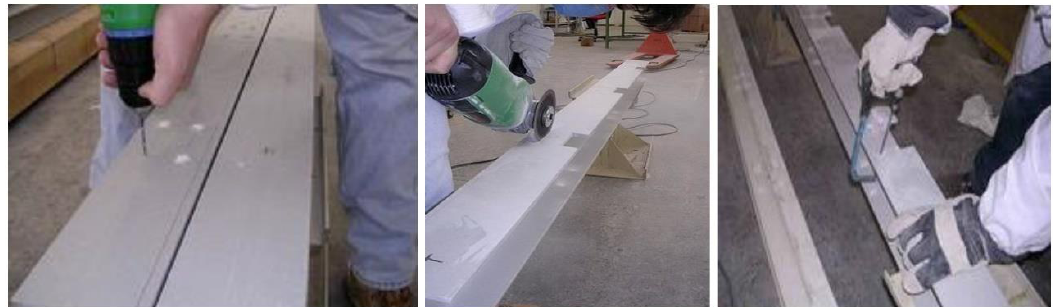
Figure 4. Notching procedure of the GFRP profiles.